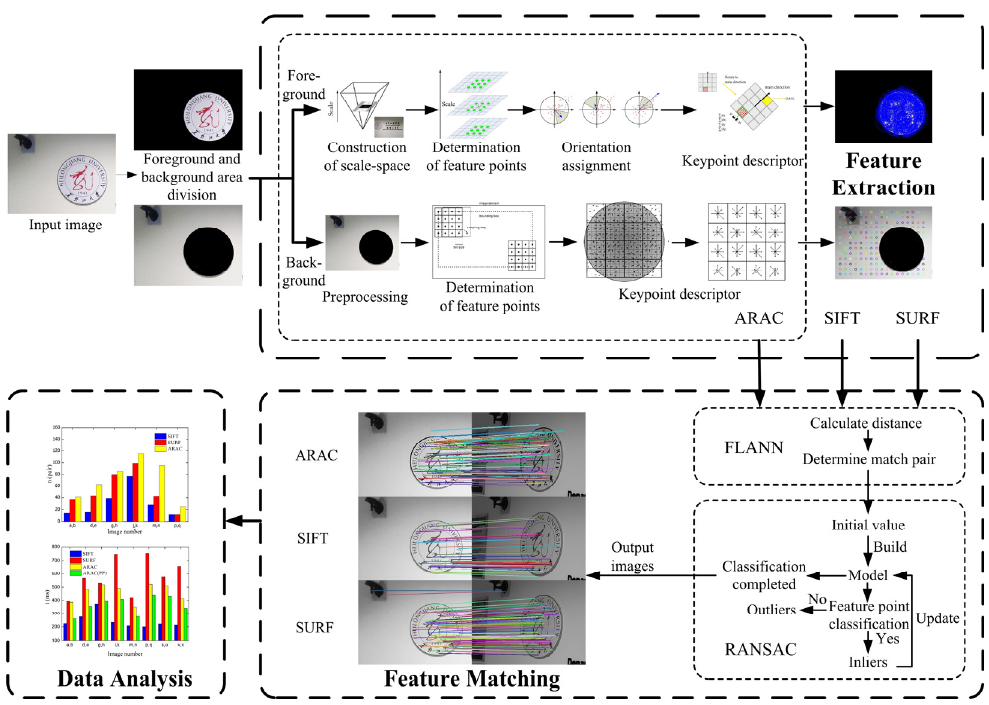
Figure 1. Roadmap of the research. In the data analysis, blue, red, yellow, and green represent SIFT, SURF, ARAC, and ARAC under parallel processing, respectively.